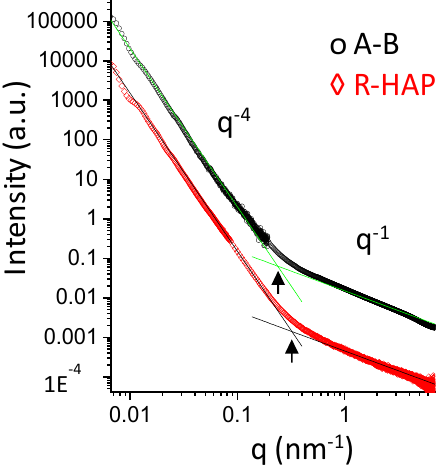
Figure 4. SAXS spectra of A-B and R-HAP regions. Straight lines represent the two different pow- er-low of the scattered intensity decay: I(q) ÷ q − 4 in the low-q range, I(q) ÷ q − 1 for q > 2×10 − 1 nm − 1 in the A-B region, and at q > 3×10 − 1 nm − 1 in the R-HAP region.